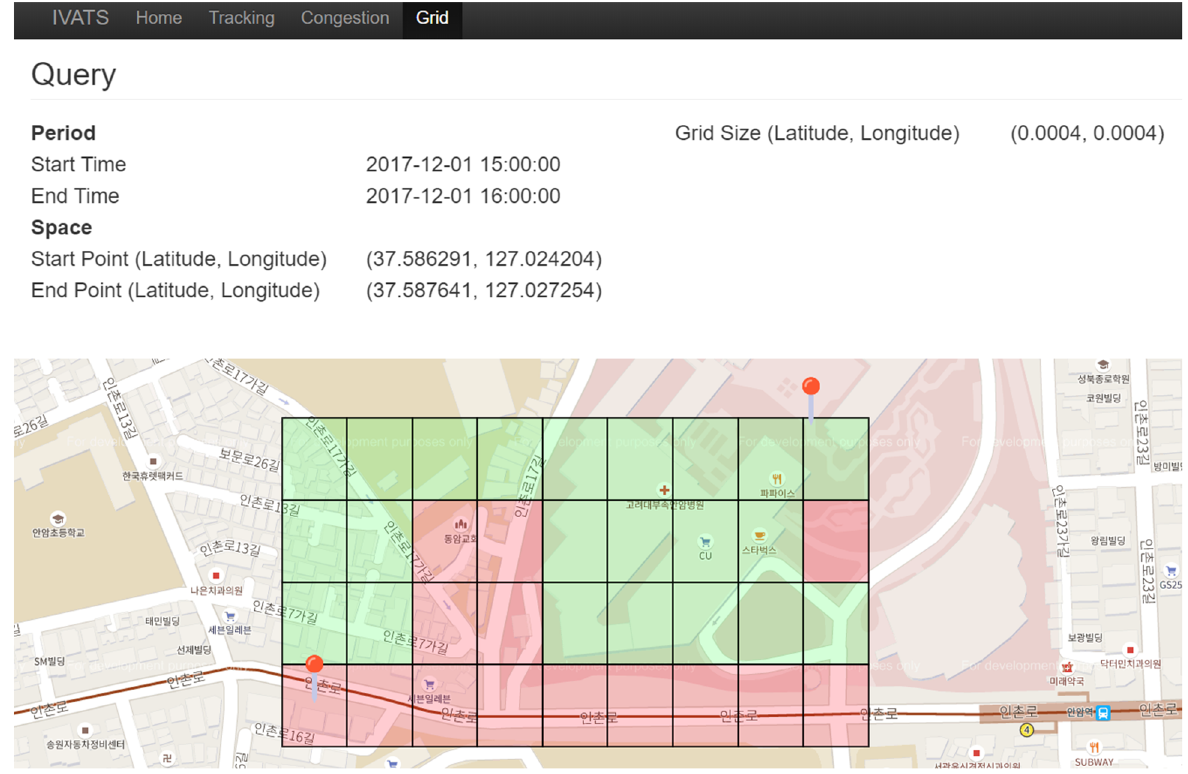
Fig. 9 An example of congestion checking in a spacious